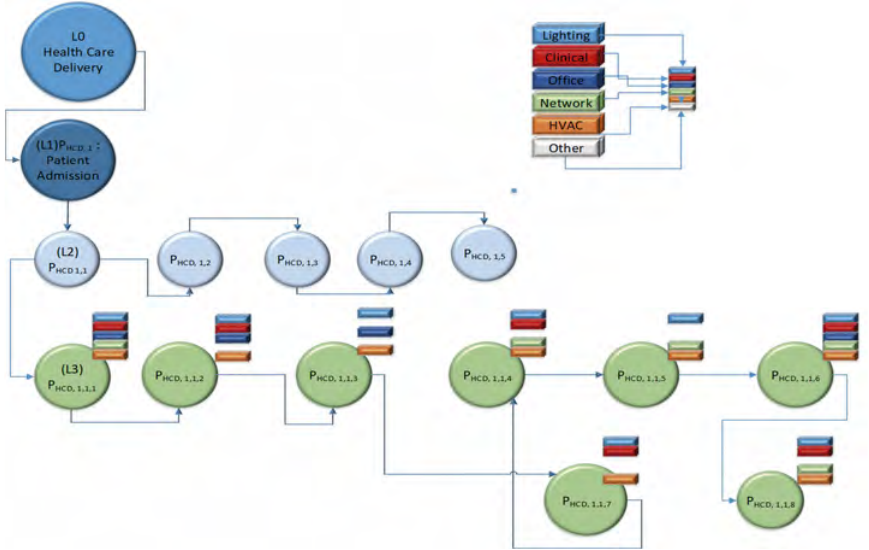
Figure 3. Sequencing of business processes to discrete event